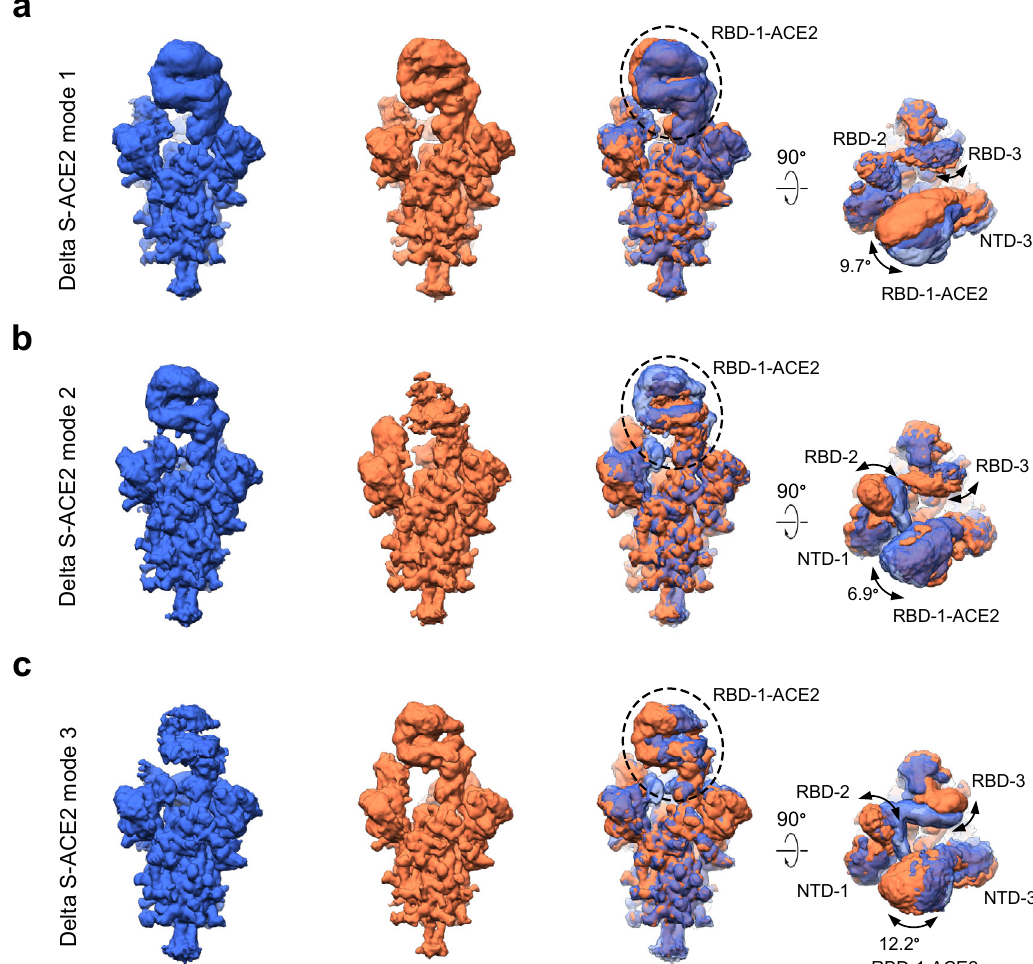
Fig. 3 3D variability analysis on the delta S-ACE2 complex. a – c Three representative 3DVA modes of the Delta S-ACE2 complex, with the left two maps showing the two extremes in the motion, and the angular range and direction of the motion displayed in the two views of the overlaid two extreme maps